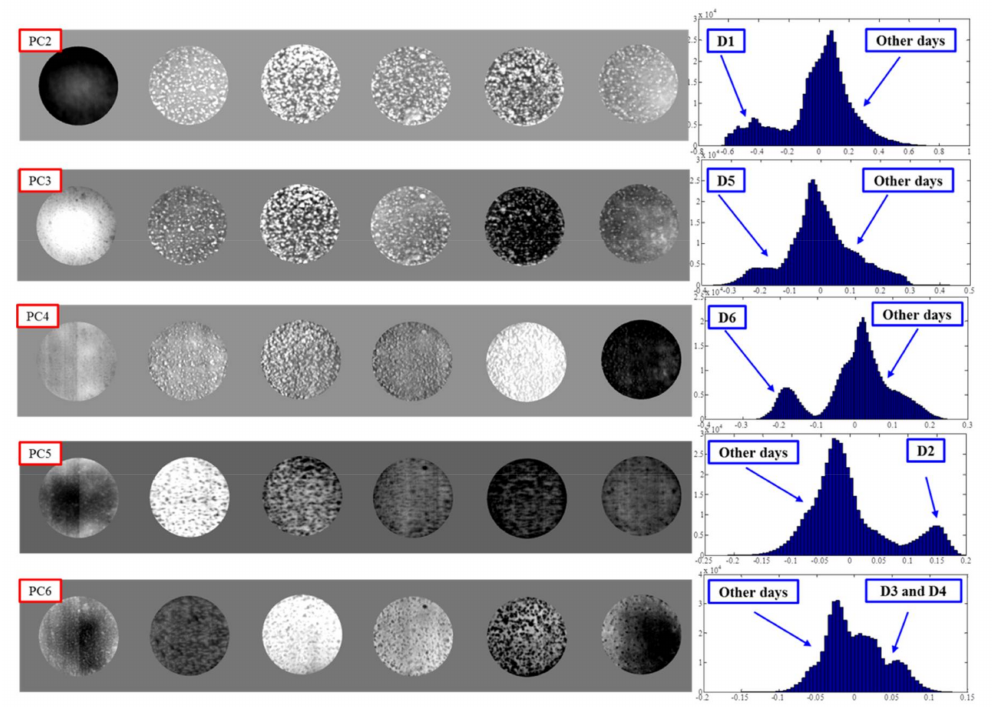
Figure 5. The second to sixth principal components (PC 2 to PC 6 ) images of A. flavus